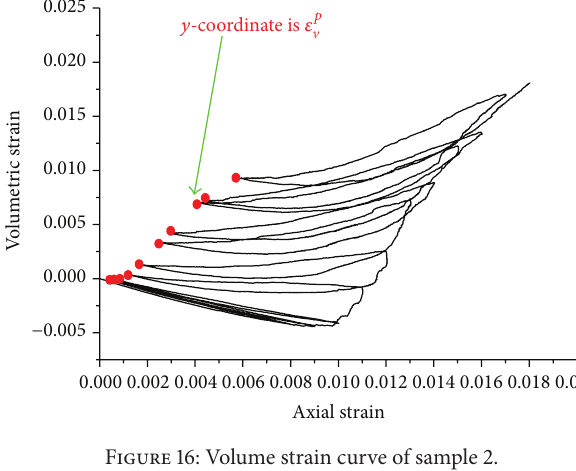
Figure 15: Loading and unloading of sample 2. Figure 16: Volume strain curve of sample 2.